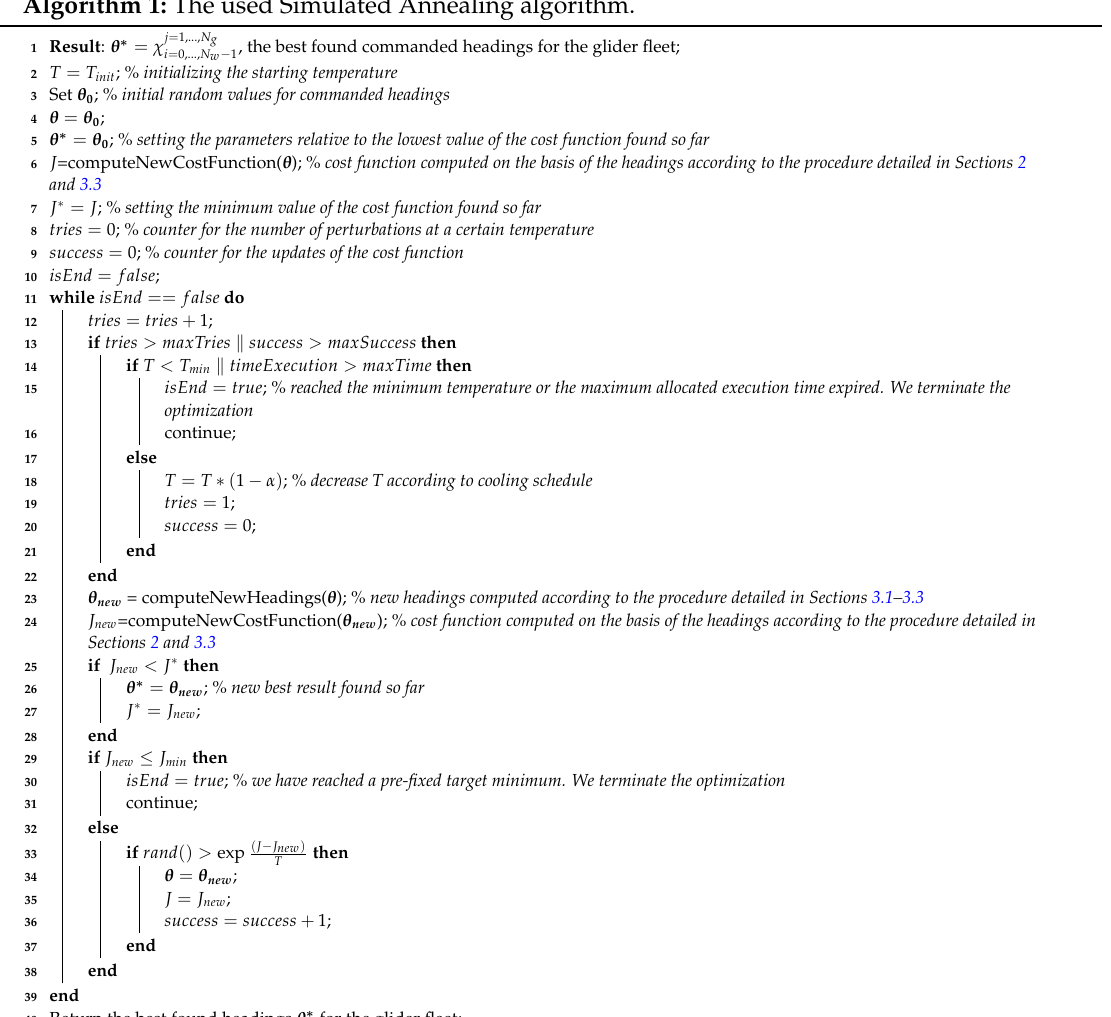
Algorithm 1: The used Simulated Annealing